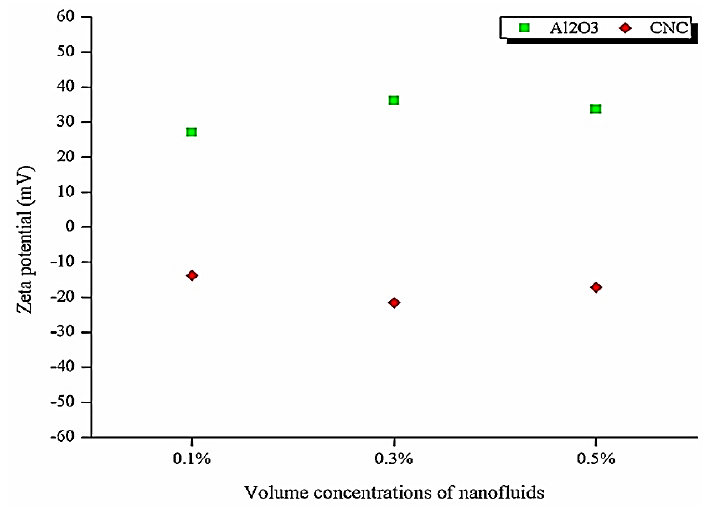
Figure 6. Quantitative analysis of the stability of nanofluids [42].